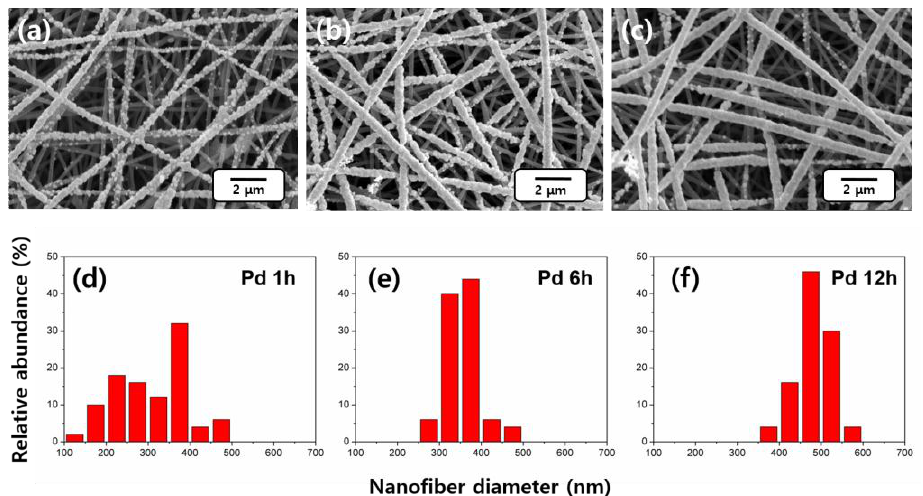
Figure 2. Scanning electron microscope (SEM) images of chemically deposited Pd ions on CNFs with different times: ( a ) 1 h; ( b ) 6 h; ( c ) 12 h. The images are accompanied by the corresponding diameter distributions in ( d – f ).